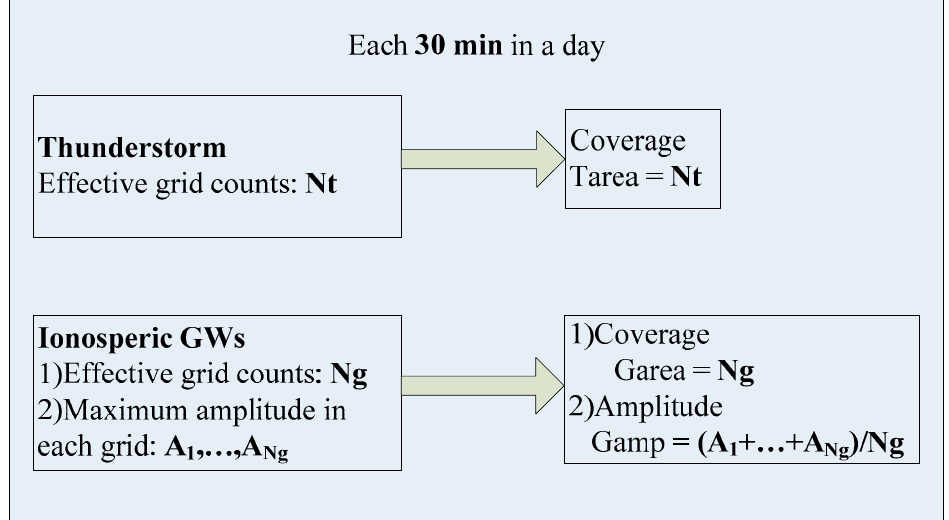
Figure 2. Diagram for the computation of statistical parameters.